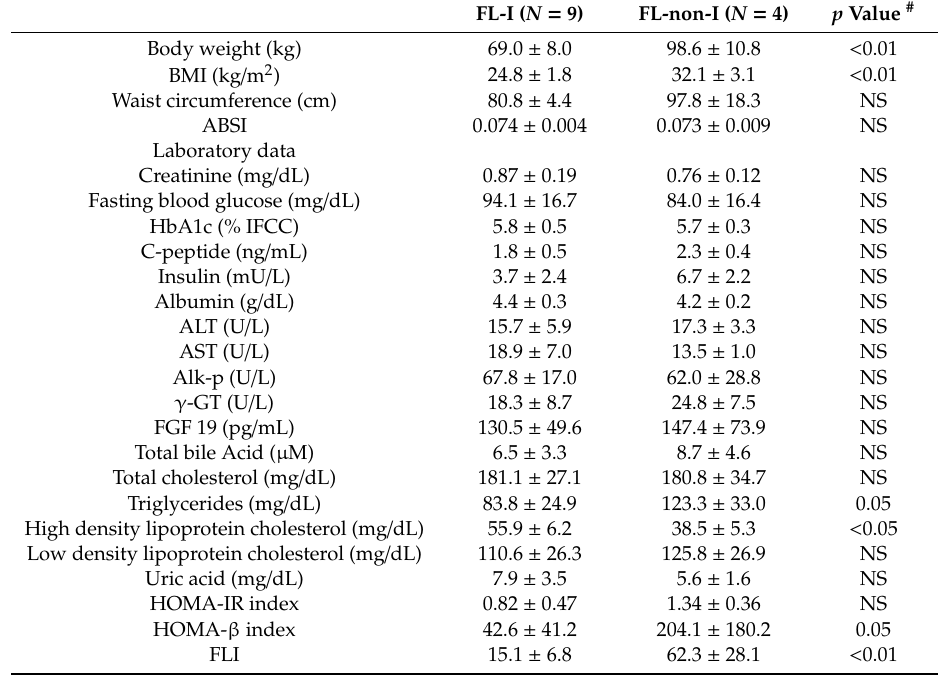
Table 3. Characteristics of patients with obesity and type 2 diabetes mellitus 1 year after sleeve gastrectomy between the improvers of fatty liver (FL-I) and non-improvers of fatty liver (FL-non-I) based on the